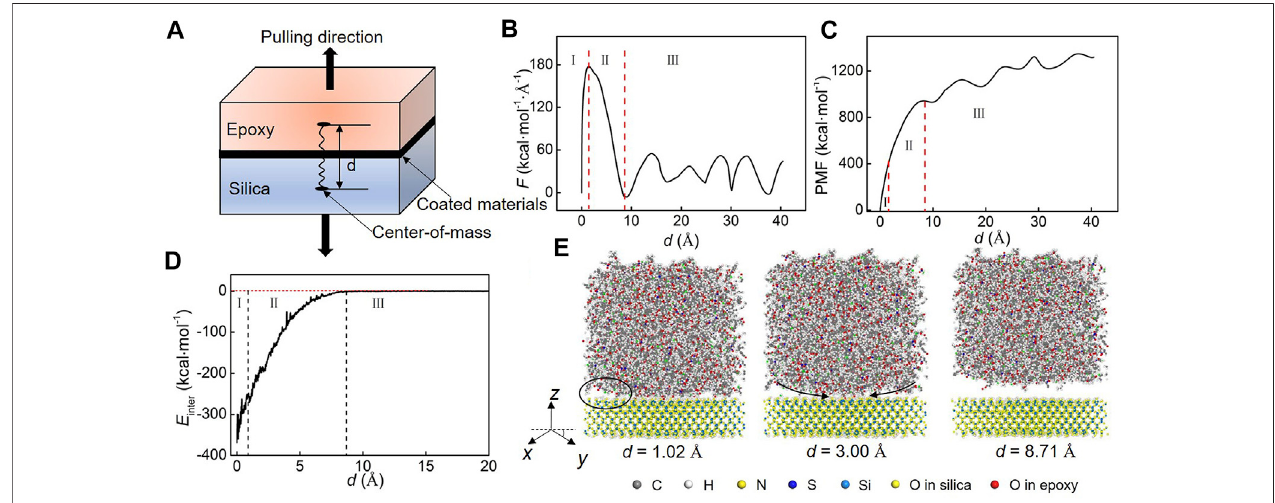
FIGURE3|(A) Schematicdiagramforinterfacialdebondingofepoxy/silicasystemsbySMDsimulations. (B) Forcecurveasafunctionofdisplacement d. Theforce curveisdividedintothreestages:rapidincrementtothemaximumvalue,decreasetoaboutzero,and fl uctuationaroundzero. (C) PMFcurveasafunctionof d wherethe PMF reaches the local maxima at the end of stage II. (D) Interfacial energy change as a function of d . The interfacial interaction is reduced to zero at the end of stage II, indicatingthecompletedebondingbetweenepoxyandsilica. (E) Conformationalchangeoftheinterfacialstructureduringpulling.Thedebonding fi rstoccursatthe edge of the surface and propagates into the inner. The interface fails at the contact surface between epoxy and silica.